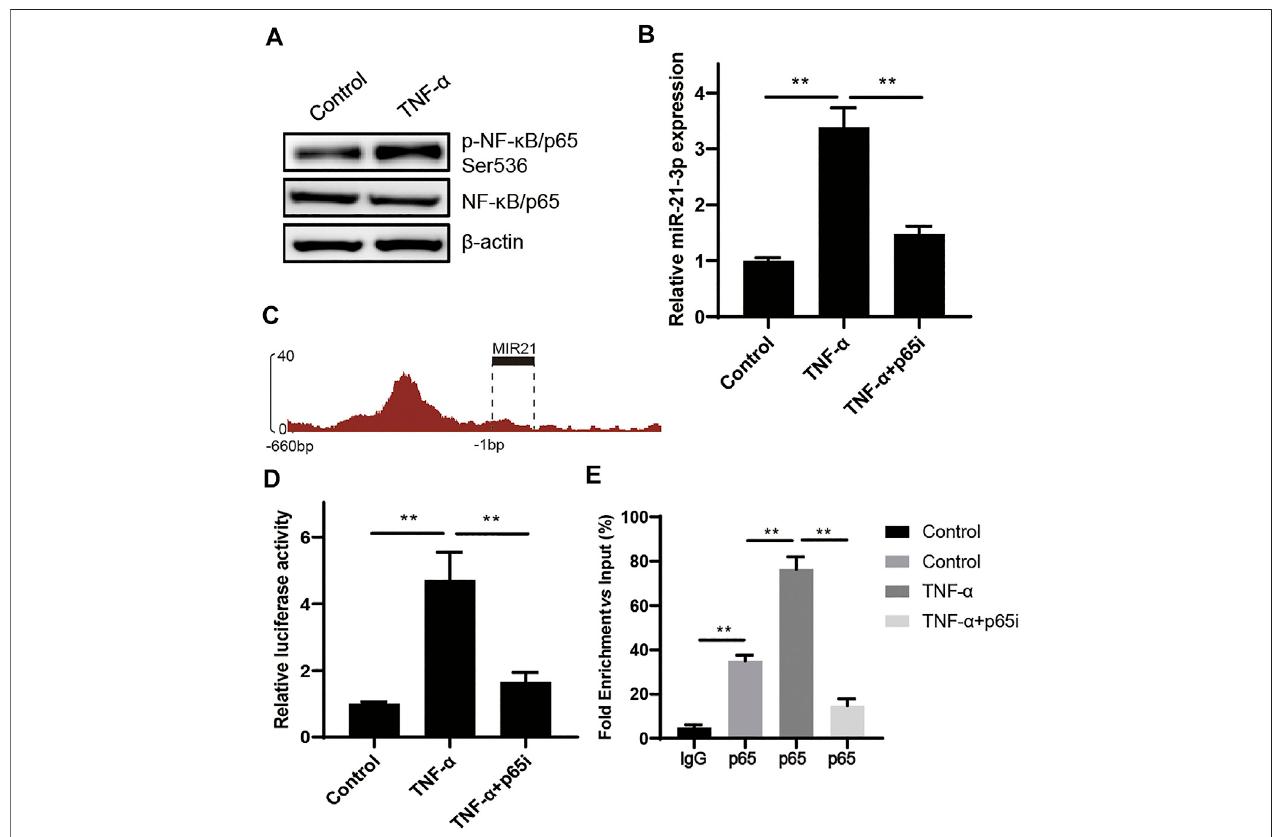
FIGURE 2 | miR-21-3p is upregulated by TNF- α through the NF- κ B signaling pathway. (A) The expression of p65 and p-p65 was detected in TNF- α – induced Caco-2 cells by western blot analysis. p-p65 was drastically increased in the stimulation group compared with the control. (B) The expression of miR-21-3p was evaluated in TNF- α – induced Caco-2 cells or TNF- α and parthenolide co-induced Caco-2. The overexpressed miR-21-3p induced by TNF- α was reversed by parthenolide. (C) Schematicrepresentationofpredictedp65bindingsitesinthepromoterregionofMIR21. (D) ResultsofluciferasereporterassaysinCaco-2cells transfected with the reporter plasmid containing the MIR21 promotor region ( − 1 – − 660 bp). The activity of MIR21 promoter was promoted by TNF- α , which could be reversed by parthenolide. (E) Chromatin immunoprecipitation was performed using antibodies against p65, or a control IgG. Precipitated DNA was analyzed by qPCR using primers for MIR21. The graph shows the enrichment in DNA immunoprecipitated by the IgG or anti-p65 antibody compared with the input. ** p < 0.01.